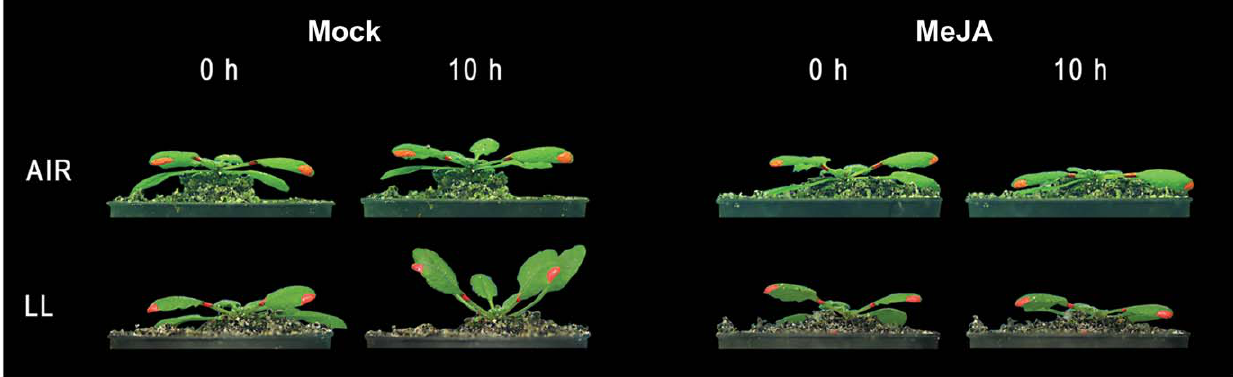
Figure 3. Typical effects of MeJA on leaf movement. Hyponastic growth phenotype of Arabidopsis Col-0 in control conditions or after 10 h low light (LL; 200 m mol m 2 2 s 2 1 to 20 m mol m 2 2 s 2 1 ) treatment in the presence of MeJA, or a mock solution. Note that the petiole-lamina border was painted to facilitate time-lapse measurement of leaf angle kinetics.